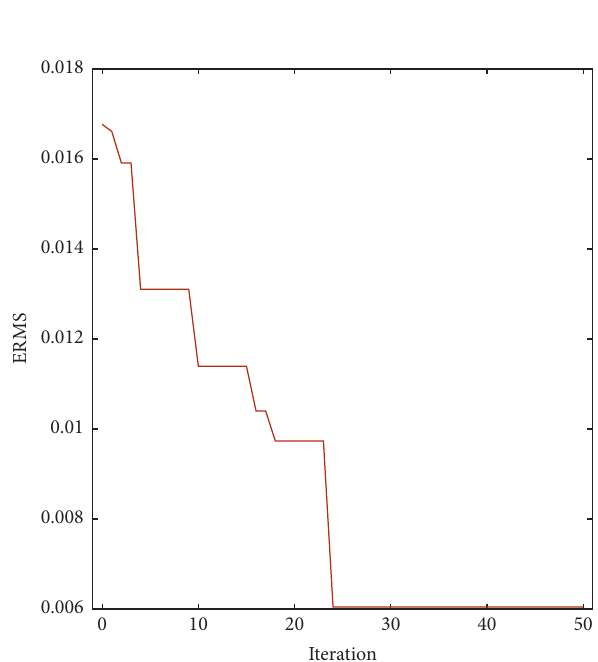
Figure 6: Relationship between the iteration and E